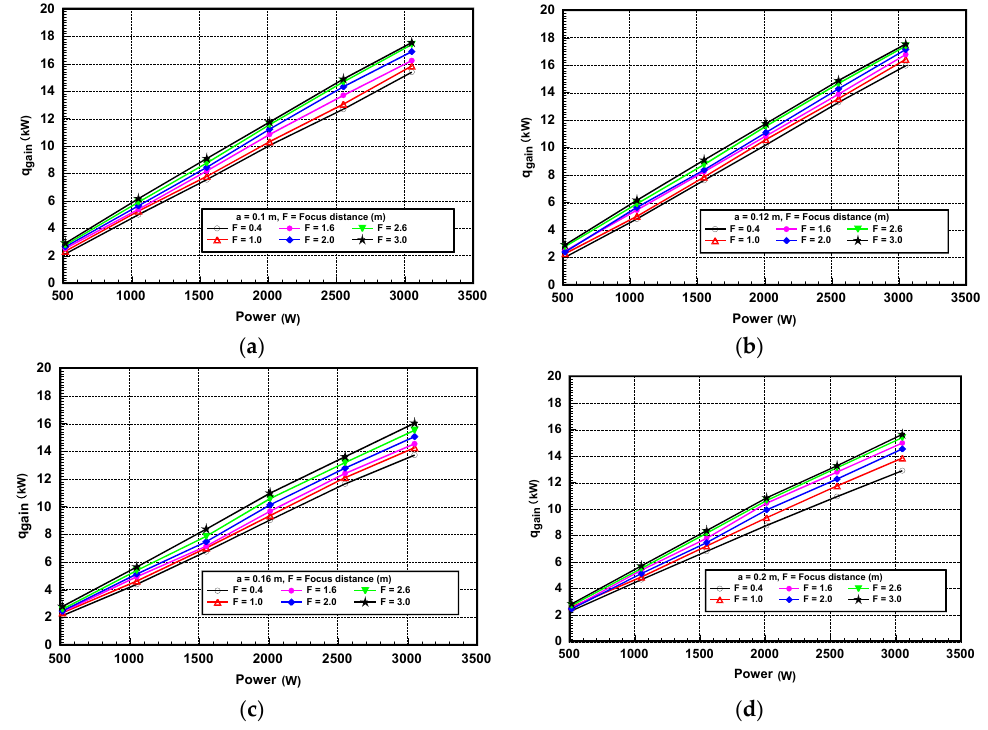
Figure 16. Gain energy of a CPV/T collector plotted against the required power with different focus distance, ( a – d ) different receiver width.